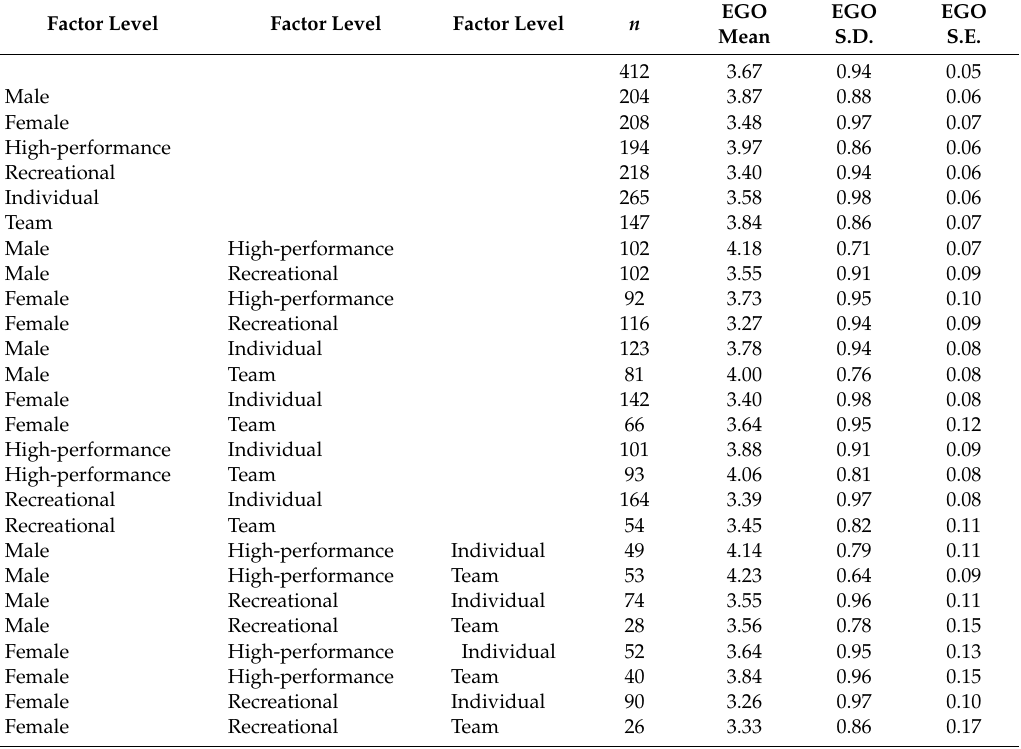
Table 6. Descriptive statistics for ego